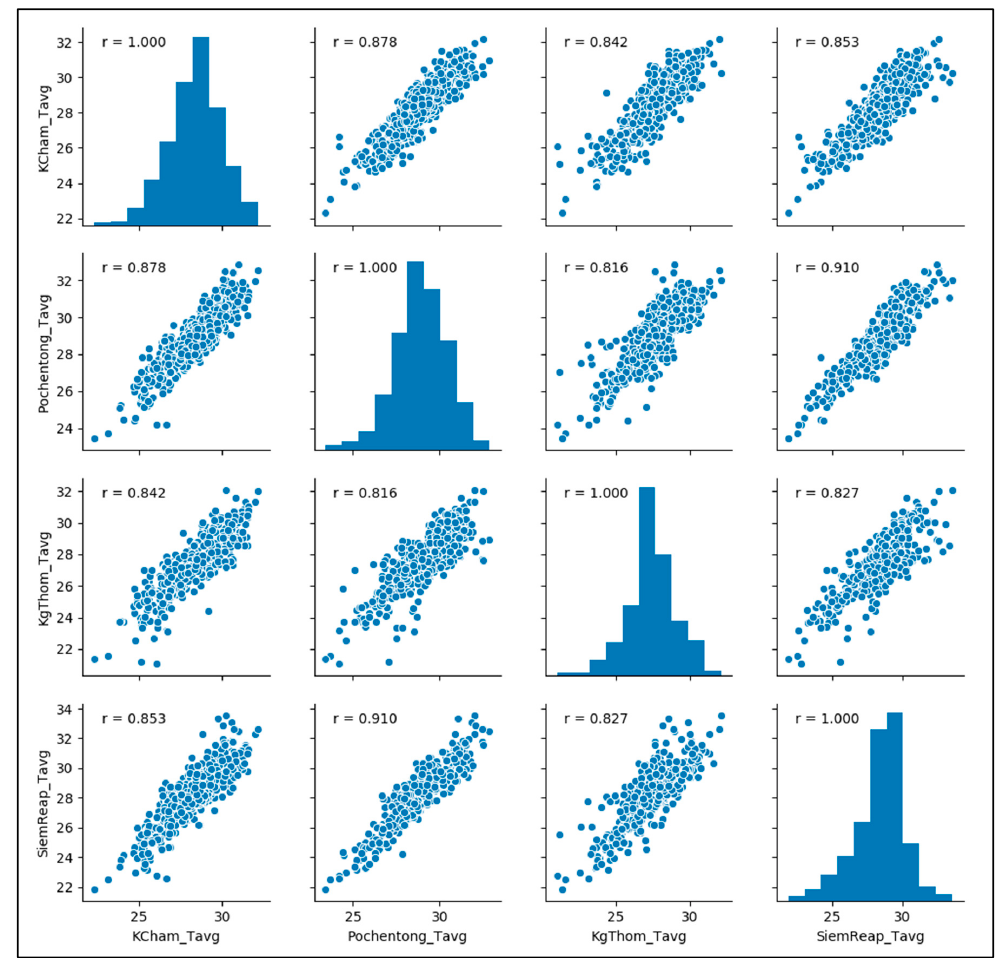
Figure A2. Comparison of weekly average temperature ( ◦ C) between each climate station with data (SiemReap, KgThom, Pochentong, KCham), for periods where data overlapped, and histograms of each station’s